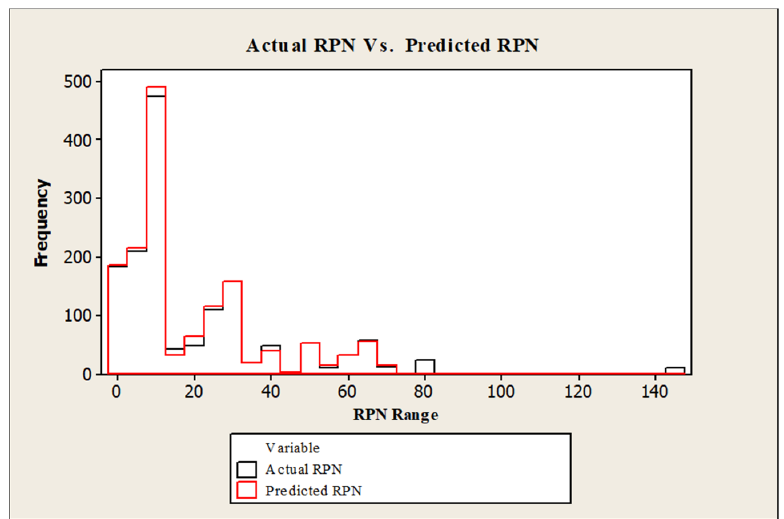
Figure 8. Originally evaluated RPN values frequency Vs Obtained RPN from the predicted Severity, Occurrence and Impact Classes.